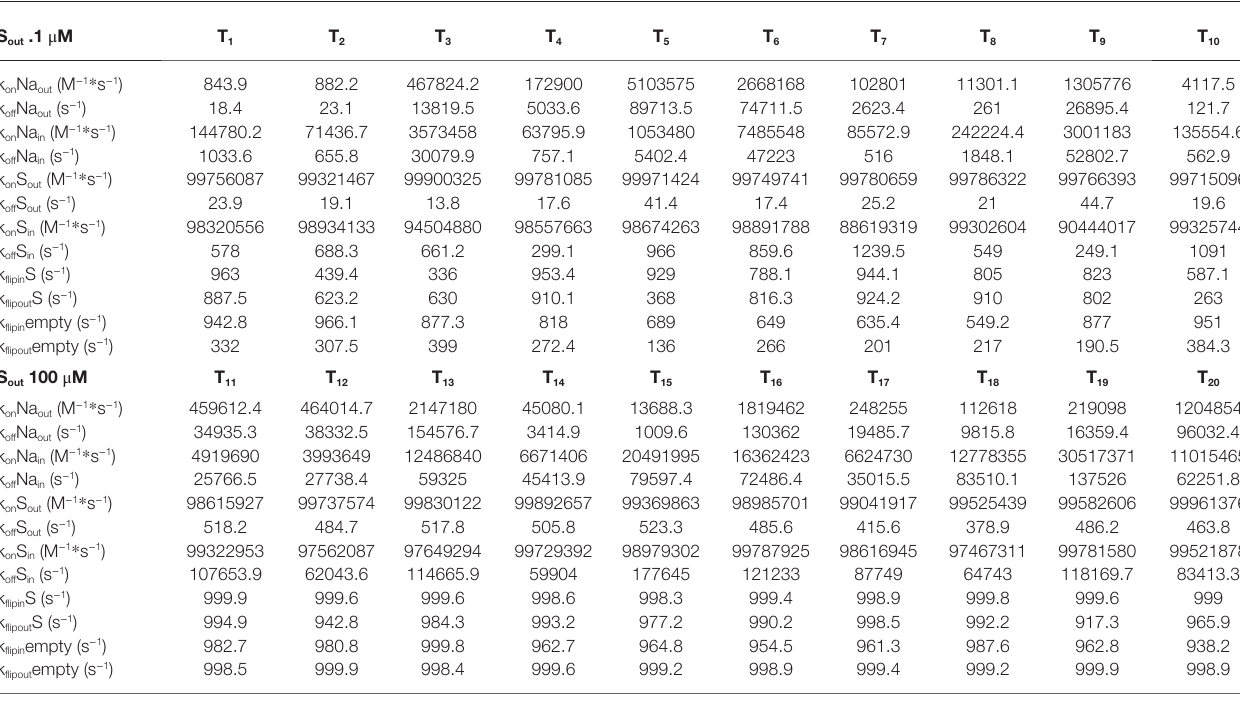
TABLE 1 | Microscopic rate constants of optimized